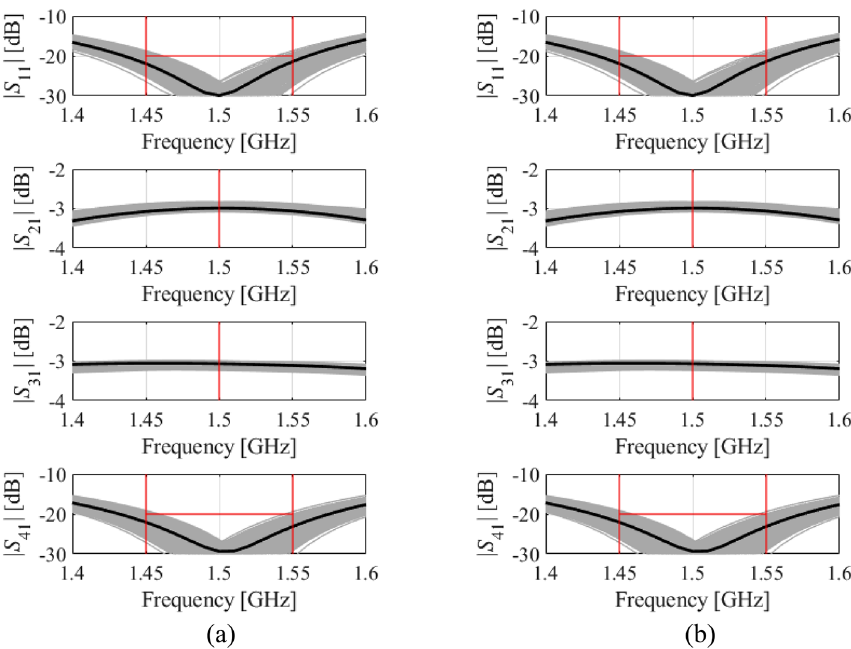
Figure 8. Visualization of EM-based Monte Carlo analysis for Circuit II ( a ) at the nominal design, and ( b ) at the optimal design rendered with the use of the procedure introduced in this work. MC is executed using 500 random data points. Gray curves represent EM simulations, whereas the circuit characteristics at the nominal ( a ) and optimal design ( b ) are shown